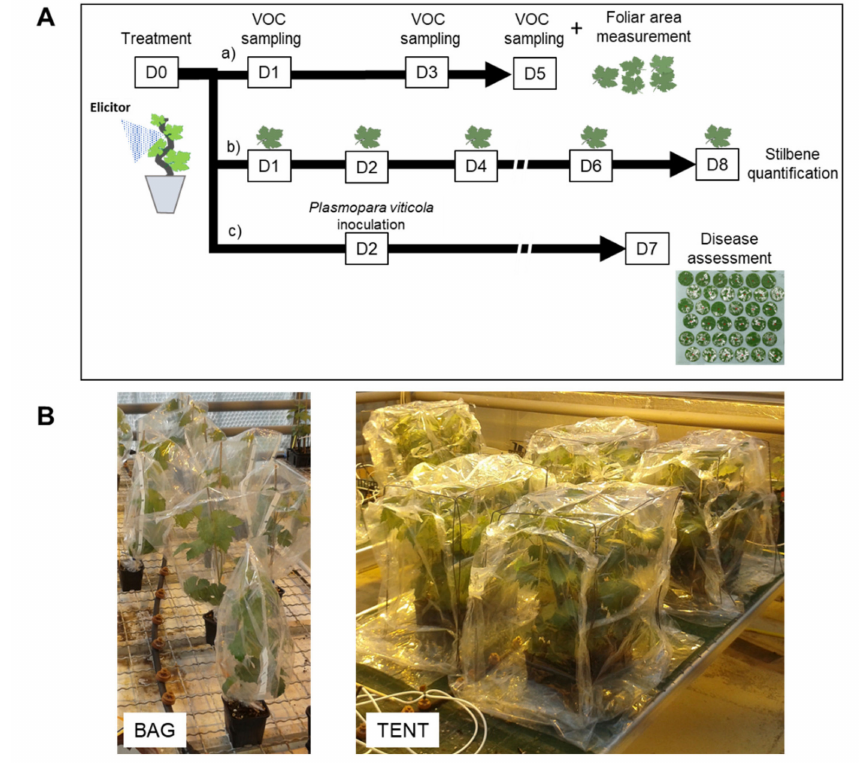
Figure 6. Experimental design. ( A ) Tests on treated grapevine plants. Elicitors or water (control) were sprayed onto the whole plants, at time D0, and then the plants were separated into three sets for further analysis. a) A first set of plants was placed into containments 1, 3, and 5 days after treatment (D1, D3, D5) for VOC sampling. At each of these time points, stir bars were installed in the foliage for 4 h. At the end of the experiment (D5), leaves were picked up to measure leaf area. b) A second set of plants served for stilbene quantification; leaves were detached on D1, D2, D4, D6, and D8. c) A third set was used to assess elicitor-induced resistance against downy mildew. The lower side of the leaves was inoculated with a suspension of Plasmopara viticola ( Pv ) sporangia on D2, and the sporulating leaf area was measured on D7. ( B ) Photographs of containment devices used for VOC